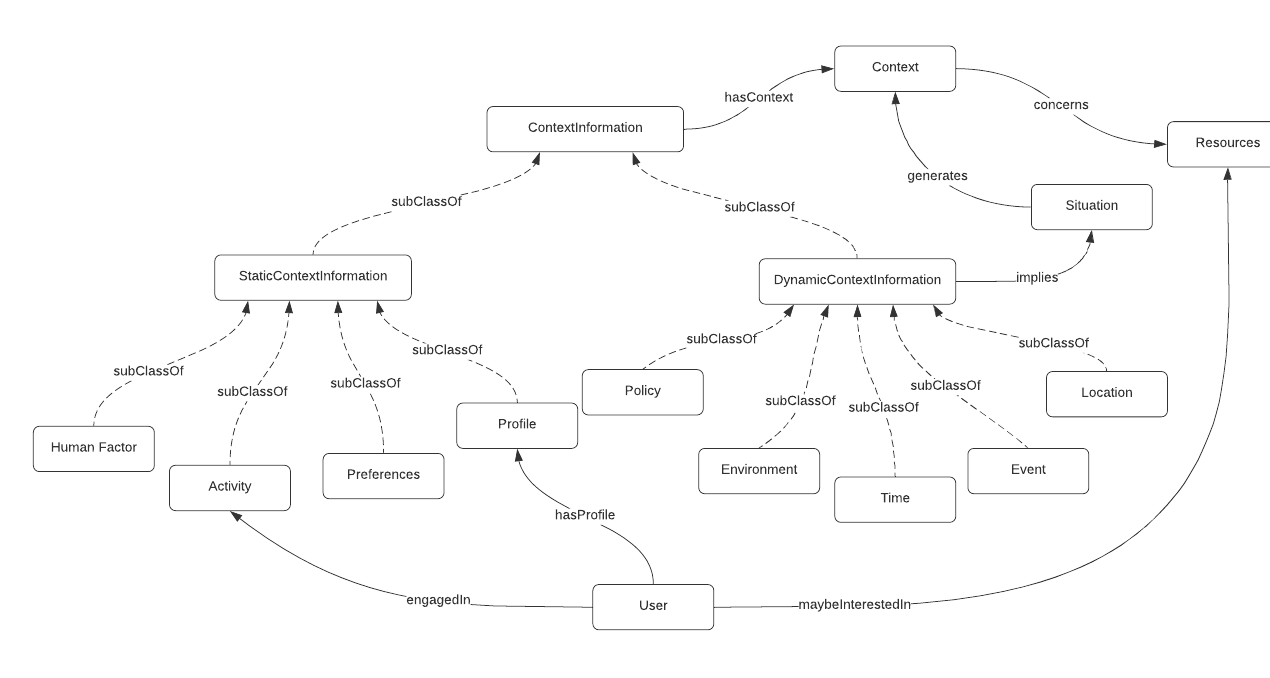
Figure 2. Overview of the proposed upper